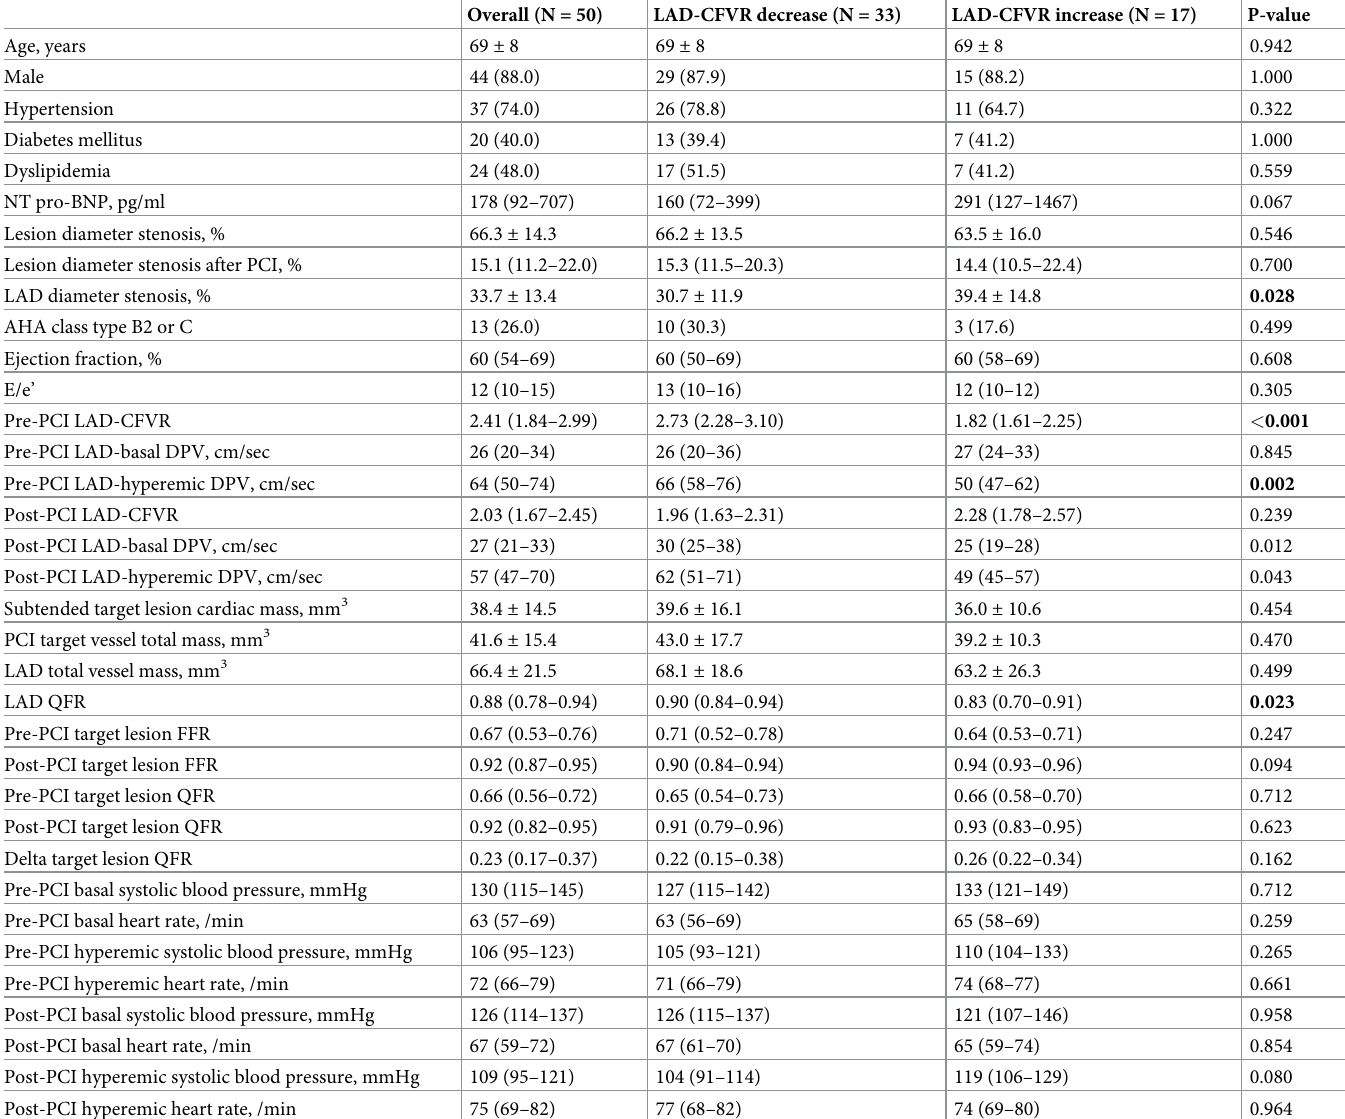
Table 1. Baseline